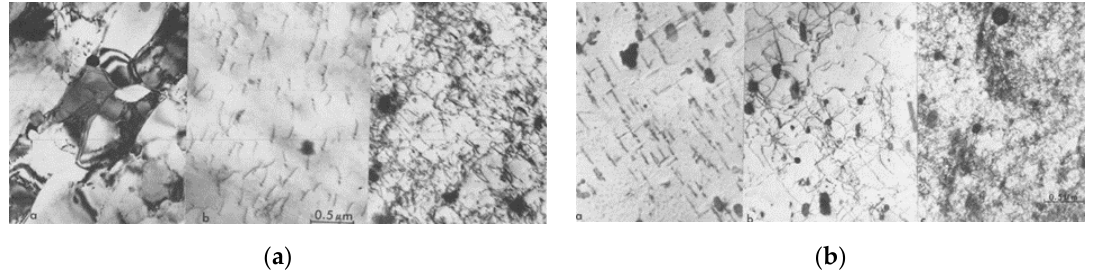
Figure 7. TEM micrographs of the microstructures of the welded and shocked aluminum alloys: ( a ) 5086-H32 alloy, left to right: as-received, weld heat affected zone (HAZ), laser shocked; ( b ) 6061-T6 alloy, left to right: as-received, weld HAZ, laser shocked. Reproduced with permission from [25], The Minerals, Metals & Materials Society and ASM International, 1977.